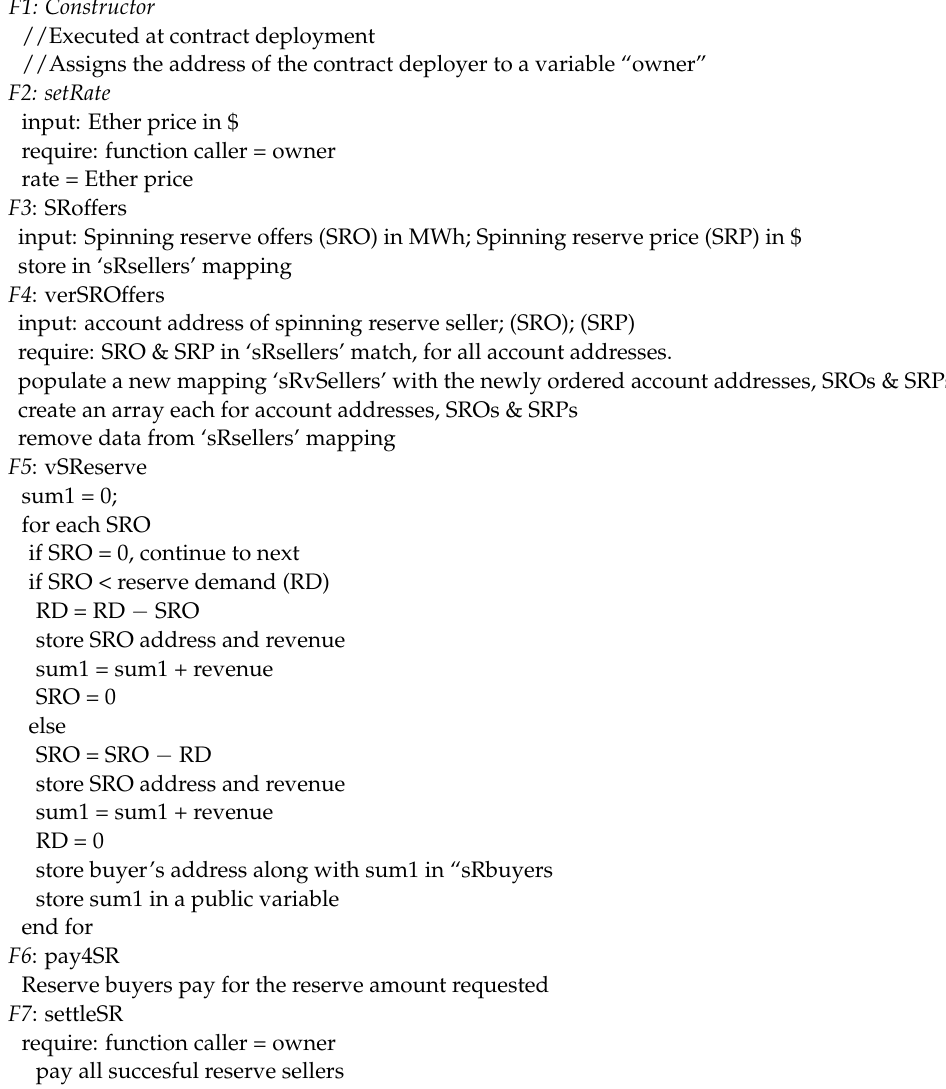
Algorithm 2 Smart contract-based reserve trading